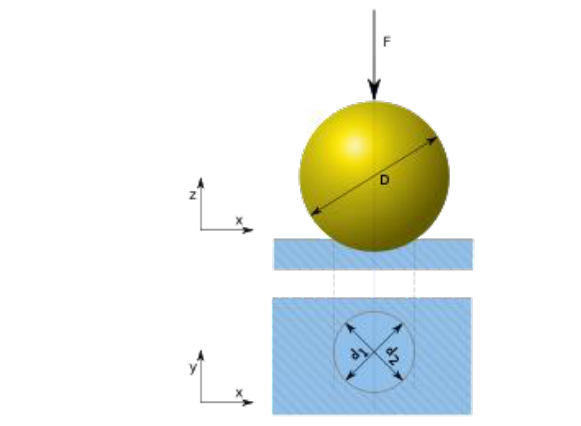
Figure 5. Measurement of Brinell’s hardness.